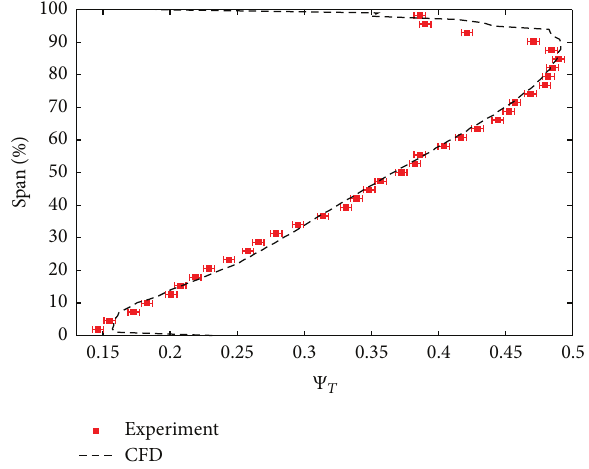
Figure 9: Comparison of measured versus predicted spanwise distribution of nondimensional stagnation pressure downstream of the axial rotor at point 9 in Figure